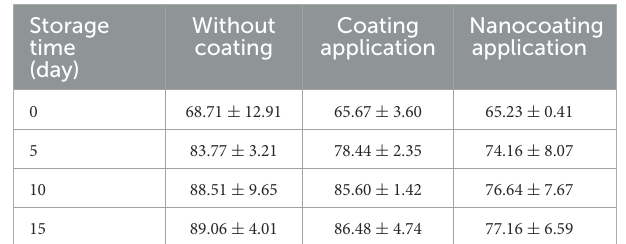
TABLE 2 Color of Siamese